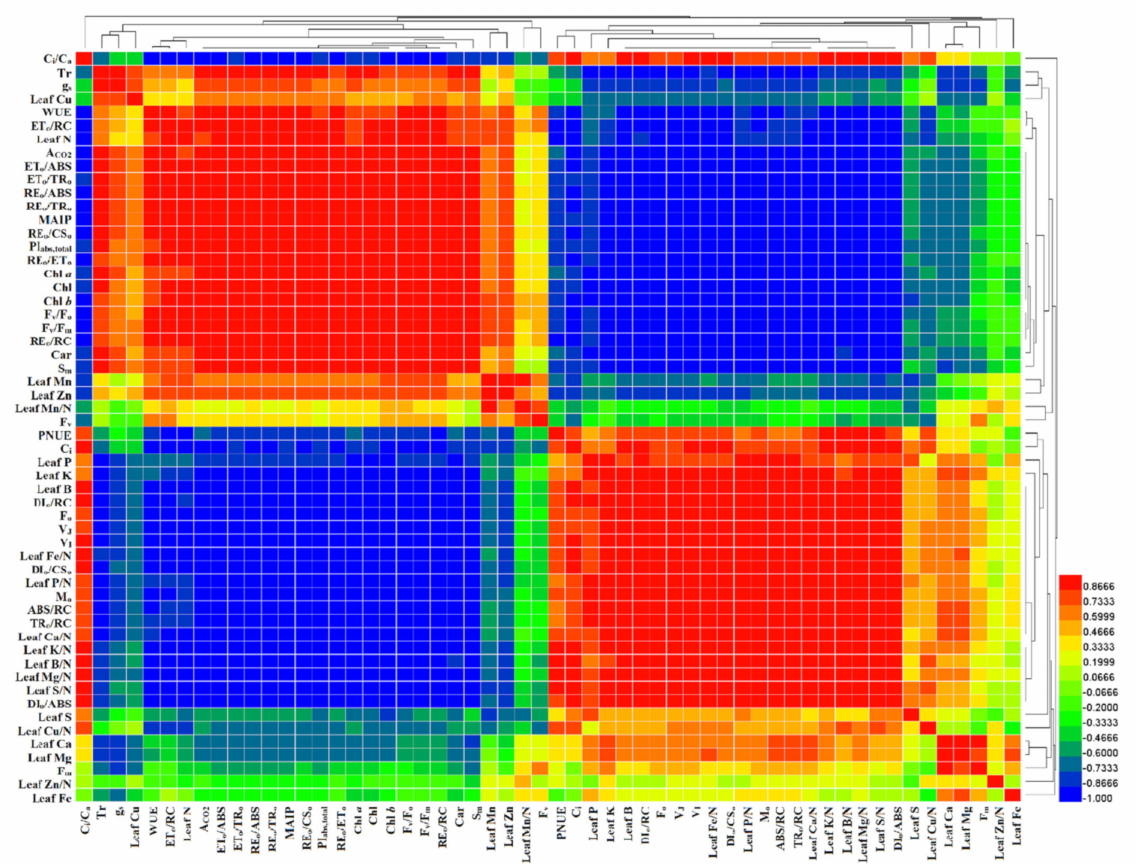
Figure 10. Matrices of Pearson correlation coefficients (PCCs) for the mean gas exchange ( n = 3–4), photosynthetic pigments ( n = 4), element concentrations and ratios ( n = 4) and fluorescence parameters ( n = 10) in C. grandis and C. sinensis leaves. A CO2 , CO 2 assimilation; MAIP, maximum amplitude of IP phase; Tr, transpiration rate. Data for element concentrations and ratios came from Figures 2, 3, S2 and S3. Data for gas exchange and pigments came from Figures 6 and 7. Data for fluorescence parameters came from Figure